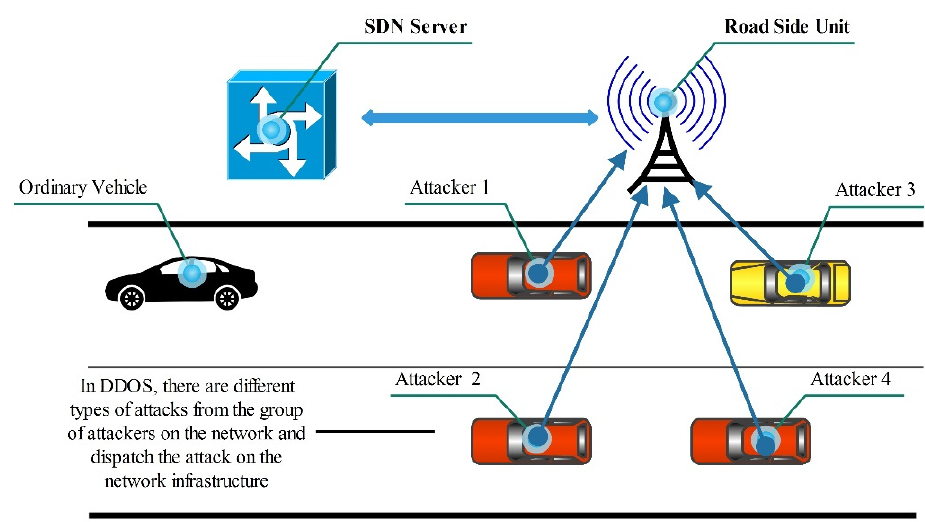
Figure 13. Distributed denial of service (DDoS) attack in SDN-based VANETs.